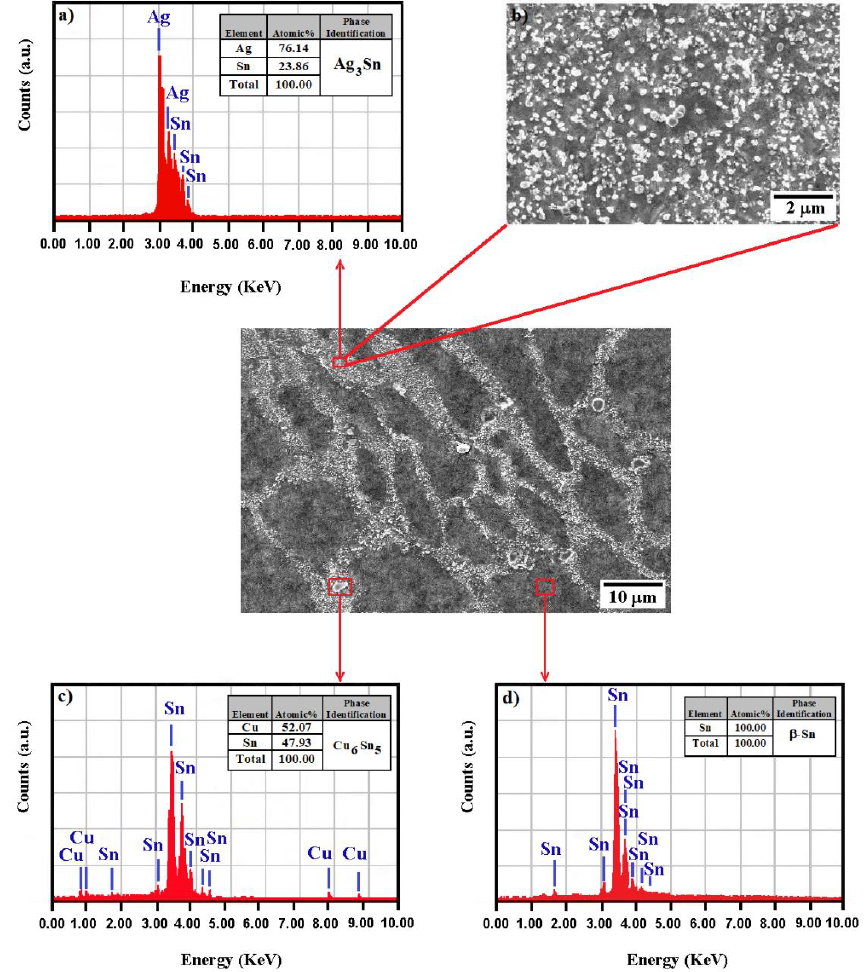
Figure 6. SEM image and corresponding EDS spectra of the SAC105 solder aged at 353 K ( a ) Ag 3 Sn phase, ( b ) magnified view showing morphology the Ag 3 Sn phase, ( c ) Cu 6 Sn 5 phase, and ( d ) β-Sn phase.